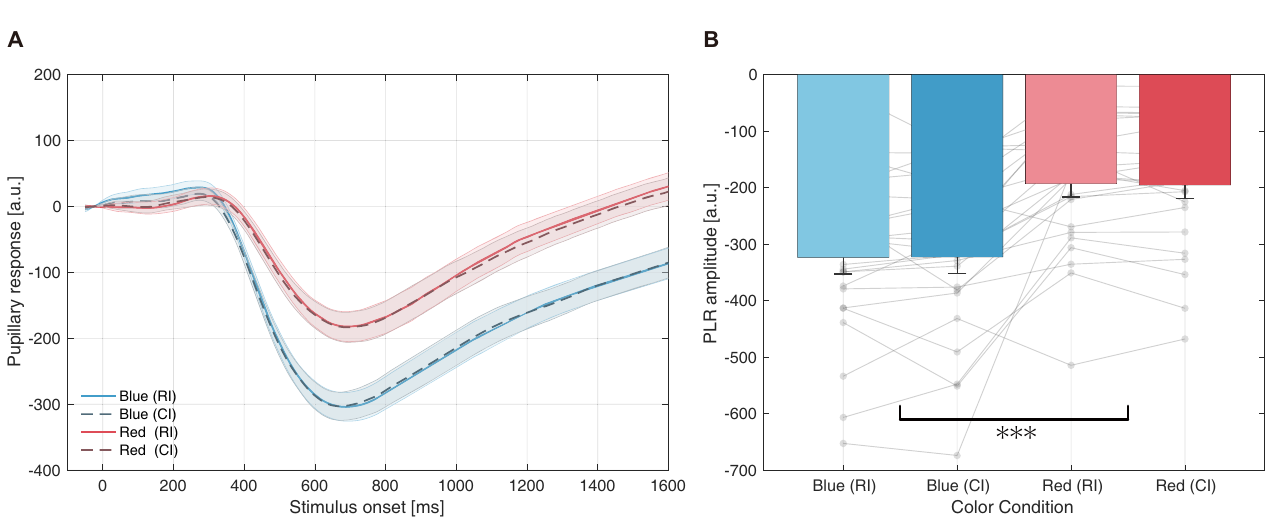
Fig 4. Pupillary response to each color stimulus (subjective equiluminance). (A) Mean change in pupil diameter from stimulus onset. Each line represents pupillary responses to RI and CI stimuli, whereas the shaded regions are standard errors of the mean. The x-axis range is limited to 1,600 ms, the shortest CI duration. (B) Mean peak PLR amplitude of each color condition. Peak PLR amplitude is determined as the minimum pupil diameter between 300–1,300 ms in the time domain. ��� Indicates a statistically significant ( p < 0.001) main effect by ANOVA. The semitransparent dots indicate each participant’s data. Abbreviations: ANOVA–analysis of variance, CI–comparison interval, PLR–pupillary light reflex, RI–reference interval.